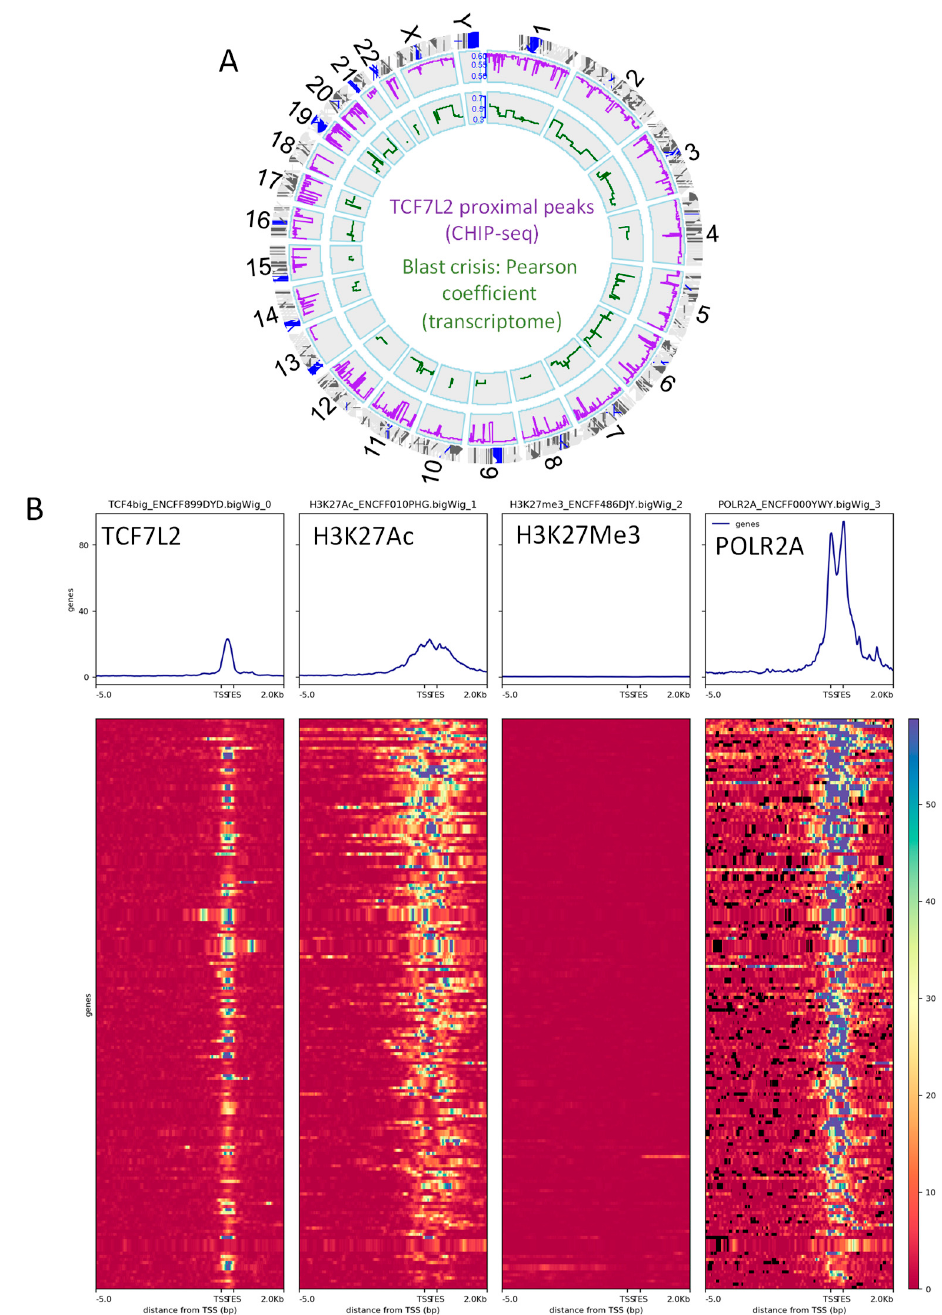
Figure 3. The integrative program of TCF7L2 in CML-BC is active for transcription: ( A ) Circos plot of the genomic landscape integrative program of TCF7L2 during the blast crisis of CML patients: the purple line represents the BETA algorithm score of proximal peaks positive for TCF7L2 in K562 cell line promoters (ENCODE data), the green line represent Pearson correlation coefficient of genes in CD34 + cells found to be correlated to the number of blasts in CML patients in BC, and the red gene symbol represent gene loci positive for the integrative analysis; ( B ) Promoter heatmap of the TCF7L2 genomic landscape positive in blast crisis of CML patients: promoter matrix was performed compared to histone mark H3K27Ac (active promoter mark) and POLR2A (positive for transcription), proximal signals were mapped from 5000 pb upstream and 2000 pb downstream from the Transcription Starting Sites